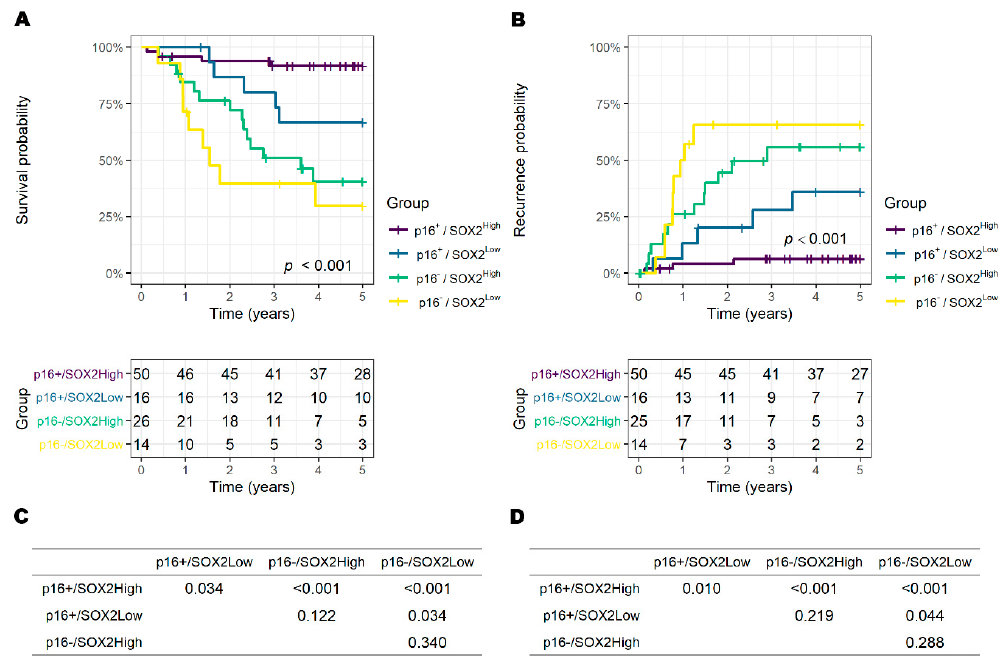
Figure 4. Survival and recurrence in four groups classified by p16+/ − and SOX2 High/Low . ( A ) The